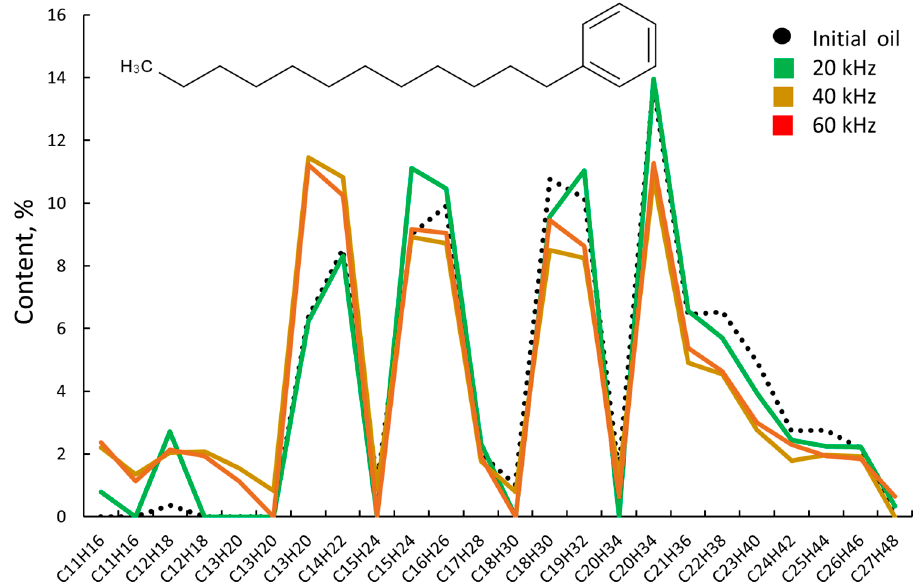
Figure 6. The relative content of alkyl benzenes in the composition of aromatics fractions of initial oil sample and sonicated oil samples under various wave frequencies.